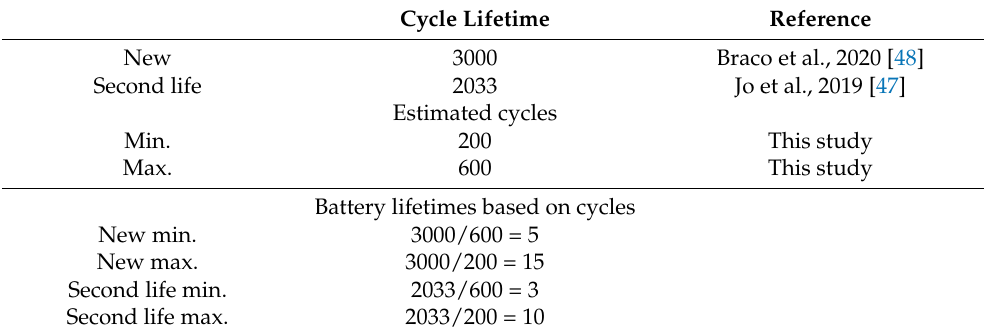
Table 4. Calculation for expected battery cycle lifetime ranges. Cycle Lifetime